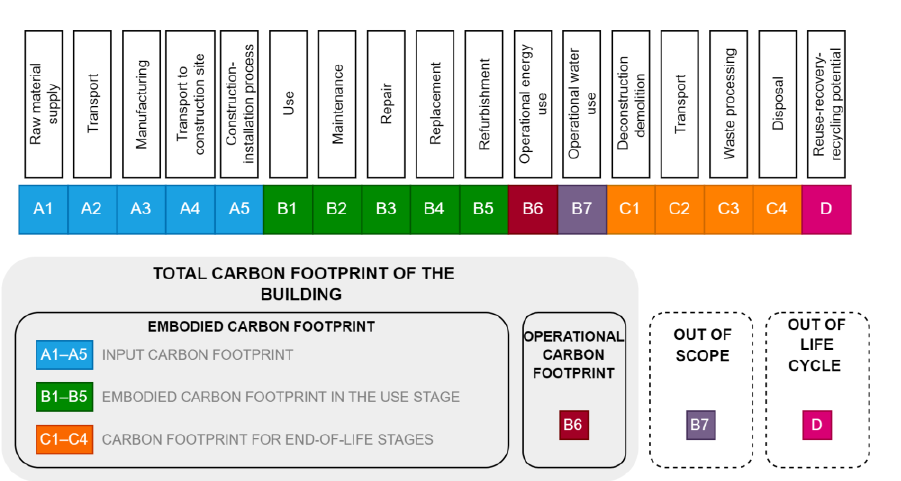
Figure 1. Types of carbon footprint from the perspective of a building structure. Own elaboration based on.